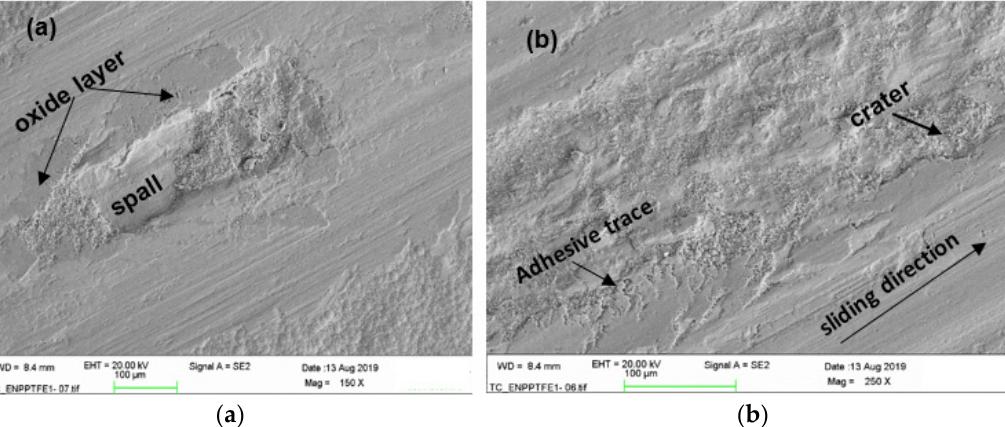
Figure 14. SEM morphology of worn zones of the developed ENP1 duplex coating at 10N load for duration of: ( a ) 6000 cycles-0.5 h and ( b ) 12,000 cycles-1 h.